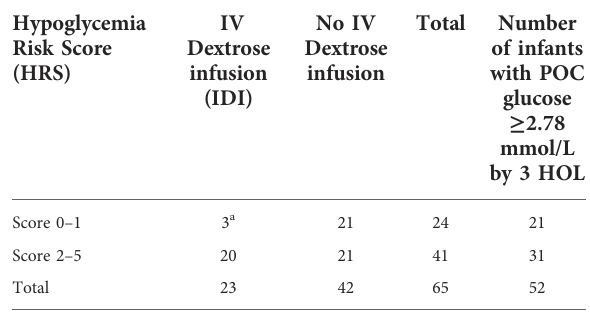
TABLE 4 Intravenous dextrose requirement and glucose resolution at 3 h of life in relation to HRS.